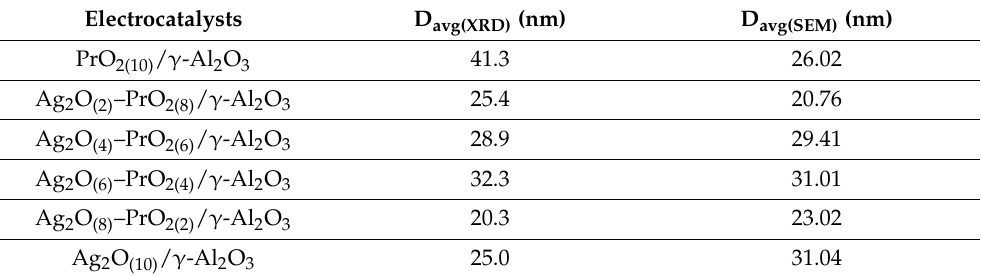
Table 1. Calculated values for average crystallite size and average particle